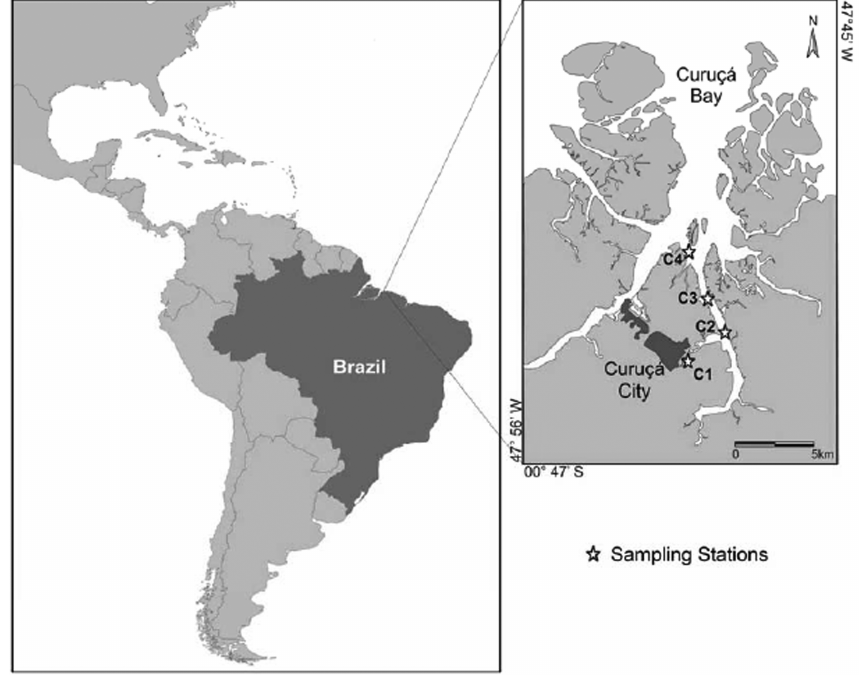
Fig. 1 – Geographical localization showing the study area with the four sampling stations (C1, C2, C3 and C4) in the Curuçá estuary (Pará, Brazil). (Modified from Hercos and Giarrizzo